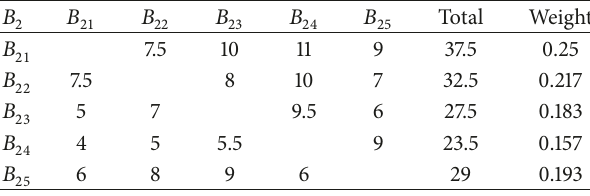
Table 12: Judgment matrix of 𝐵 2 − 𝐵 2𝑘